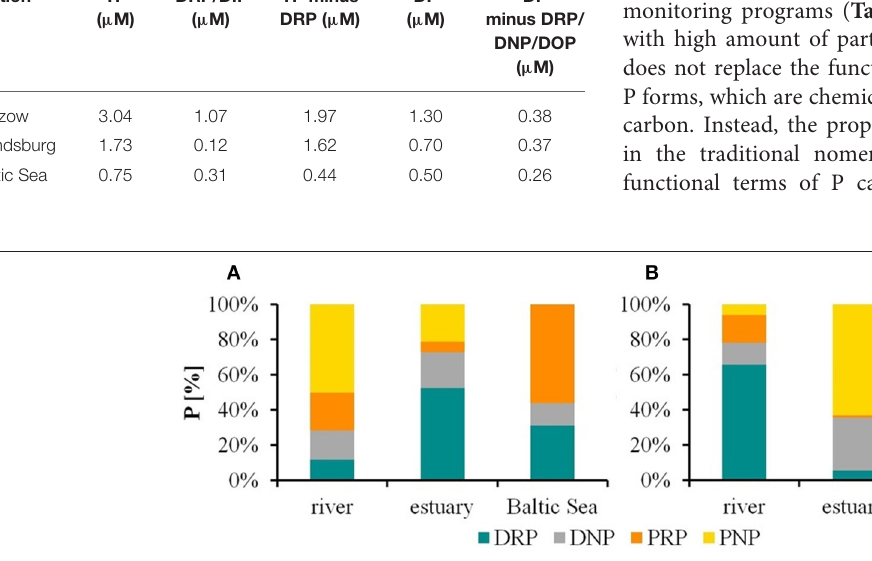
Frontiers in Marine Science |